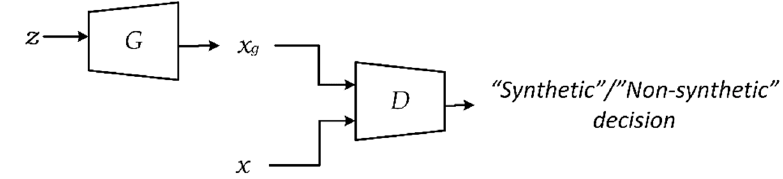
Figure 1. GAN basic